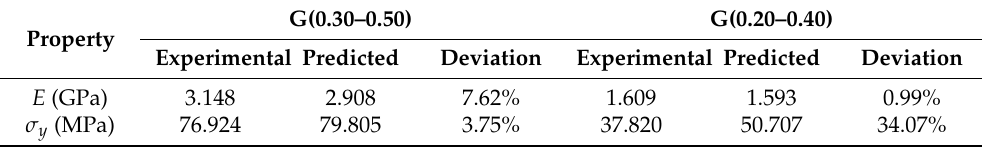
Table 2. Comparisons of experimental and predicted mechanical properties of FGLSs.